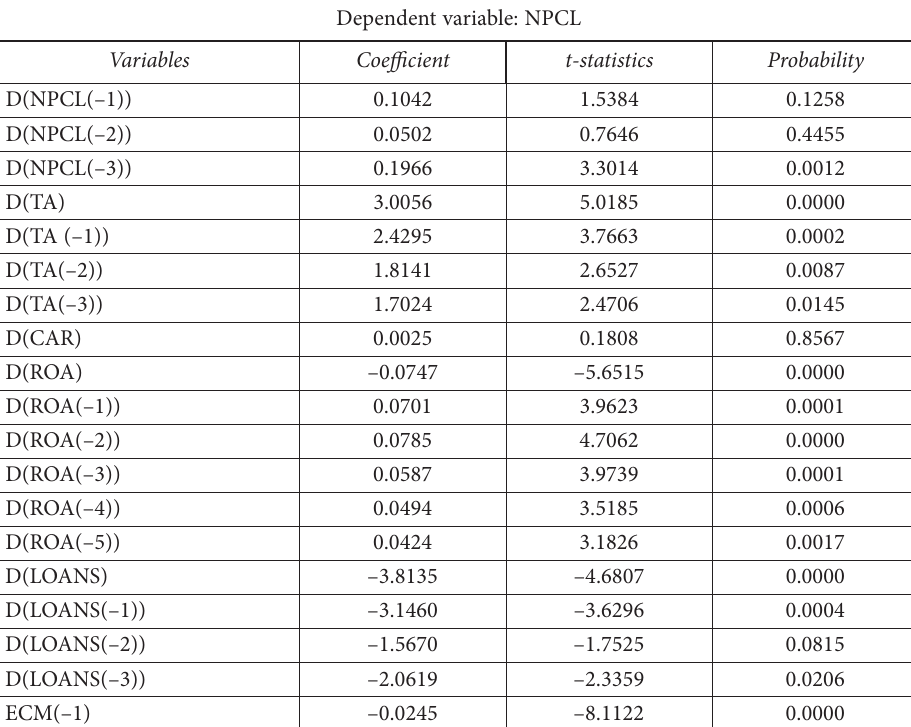
Table 9. Error correction model results (source: own calculation of